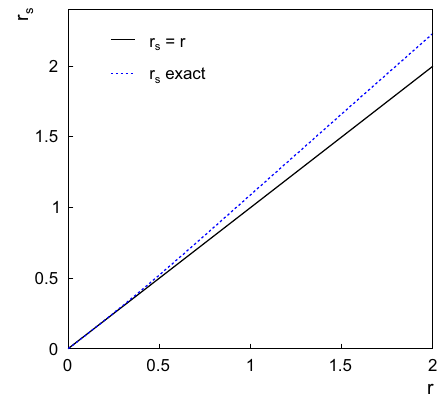
Fig. 10 The exact relative uncertainty r s as a function of the parameter r (see